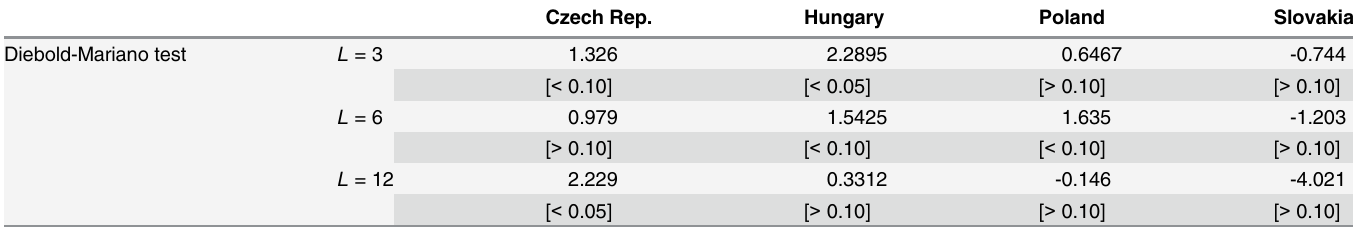
Table 4. Nowcasting summary (out-of-sample). The period between 01/2004 and 12/2011 is used for model fitting and the rest of the period between 01/ 2012 and 12/2013 is used for the forecasting comparison. Diebold-Mariano test described in the Methods section compares the “ Google model ” defined in Eq 2 to the base model defined in Eq 3 with a null hypothesis of no difference of forecasting accuracy versus the alternative of the “ Google model ” being more accurate. Czech